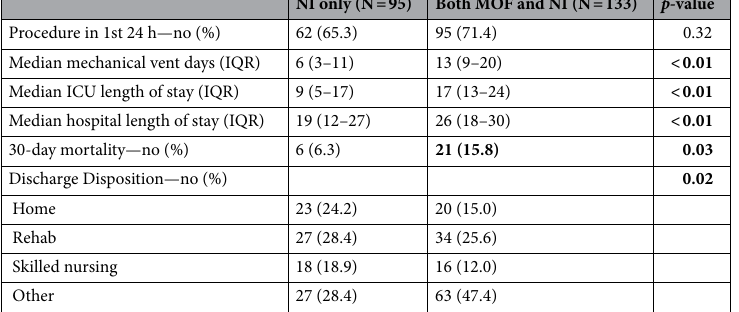
NI only (N = 95) Both MOF and NI (N = 133) p -value